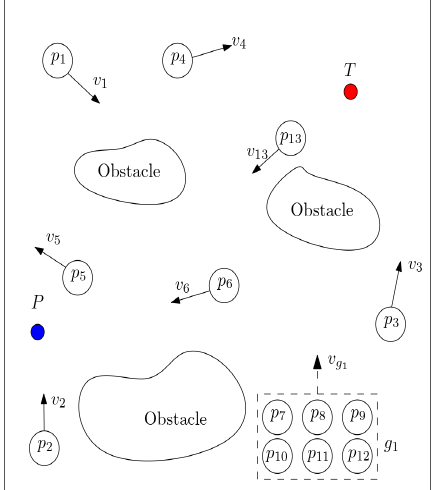
Figure 2. Schematic representation of the simulated environment: the robot spawning location and its target destination are highlighted in blue and red, respectively; three static obstacles are represented. Each pedestrian p i is indicated as a circle having its own speed v i , while the group is represented with an enveloping dashed rectangle and depicted with g i